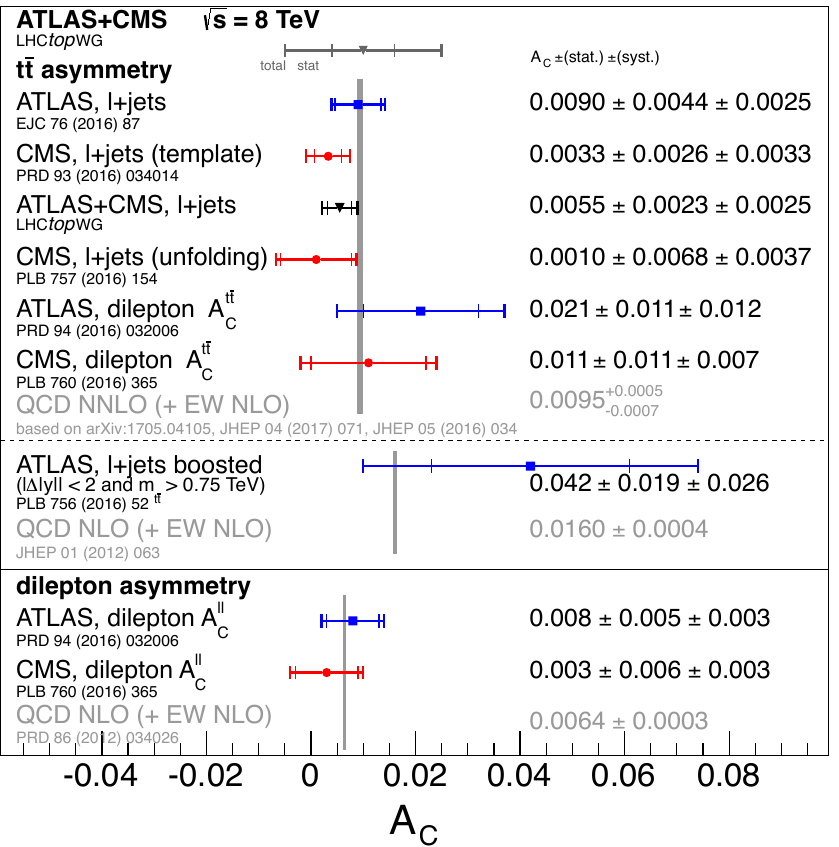
This non-trivial treatment of correlations is detailed in Ref. [35].